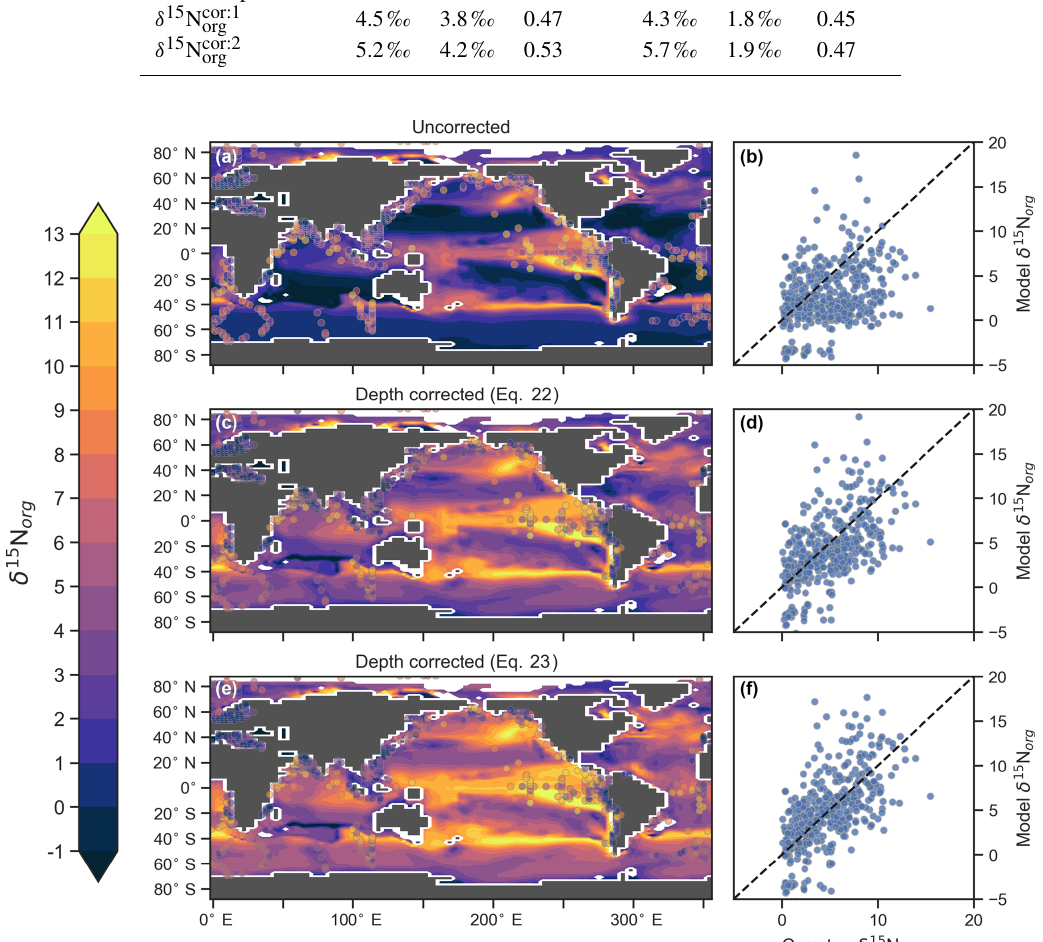
Figure 10. Direct comparison of observed versus modelled δ 15 N org incident on the sediments. Panels (a) , (c) and (e) show spatial distribution of simulated δ 15 N org overlain by core-top data from the compilation of Tesdal et al. (2013). Panels (b) , (d) and (f) compare all core-top data against simulated δ 15 N org . Panels (a) and (b) depict raw output of the model, while panels (c) – (f) depict the predicted values of the model following two depth-dependent offsets (Eqs. 22 and 23) that account for diagenetic